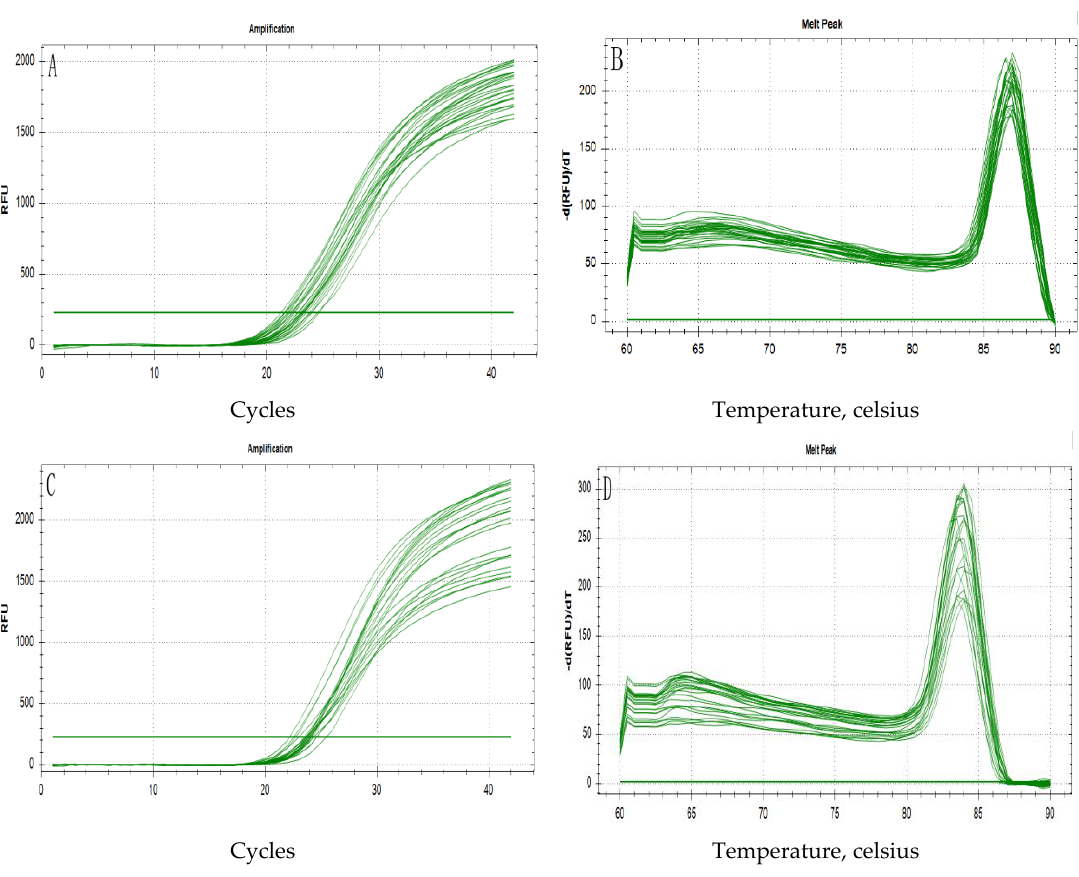
Figure 6. Amplification and melting curves based on the qRT-PCR analysis of AK1 and β-actin RNAs. A : Amplification curve for AK1 ; B : dissociation curve for AK1 ; C : amplification curve for β-actin ; D : dissociation curve for β-actin .